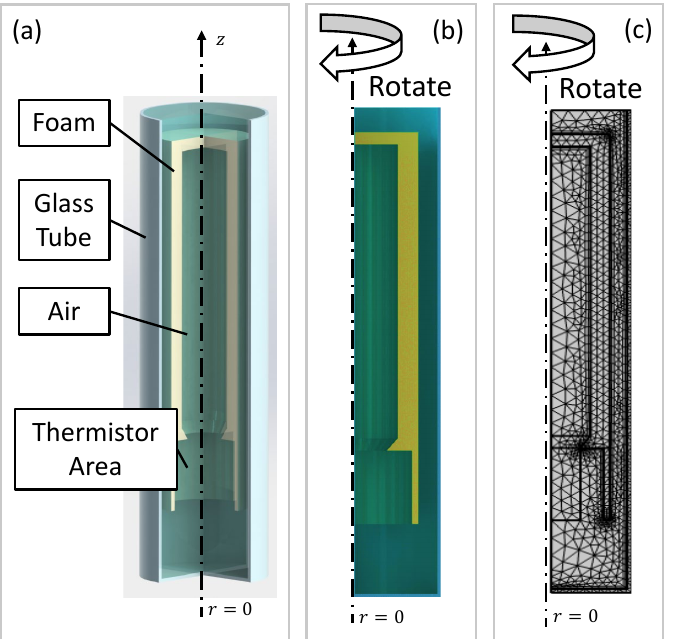
Figure 2. ( a ) Heat transfer model of Tube–Air–ADS structure diagram. ( b ) Two-dimensional struc- tures. ( c ) Grid